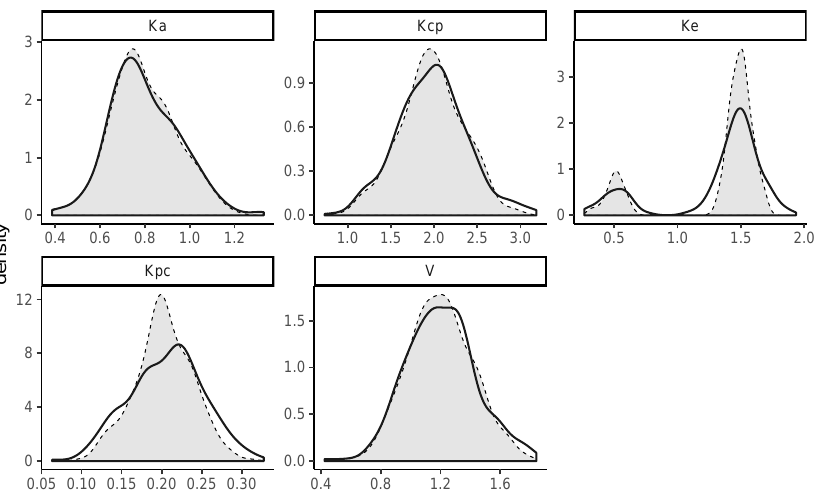
Figure A4. Kernel densities of NPAG estimated PK parameters (black line) vs. Simulated r.v.s (dashed with grey fill). K are in Hr − 1 , volume is in dL . NPAG estimation is calculated using the NPrun() function in Pmetrics . Similarity of these two distributions is verified in R using the function mtsknn.eq() . See text for further detail.